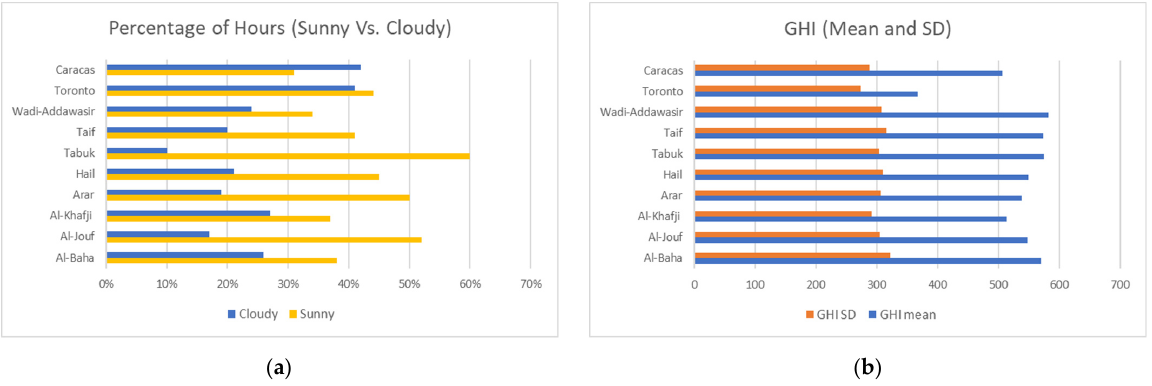
Figure 9. ( a ) Percentage of hours (sunny Vs. cloudy) of 10 datasets; ( b ) GHI (mean and SD) of 10 datasets.